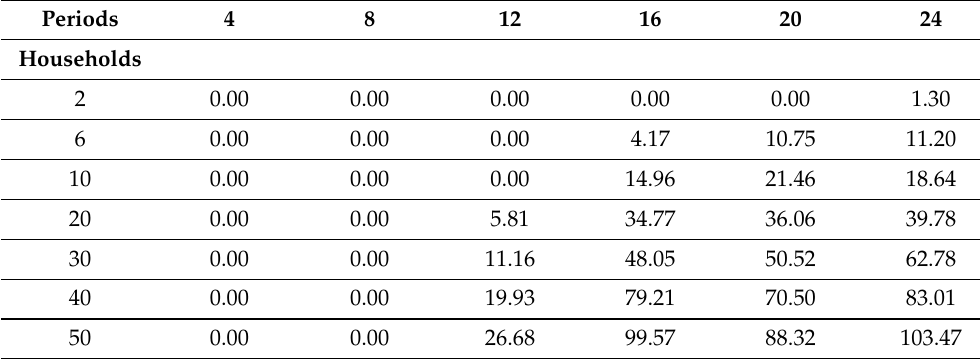
Table 3. Median cost IER values for algorithm OA by RHS Summation with